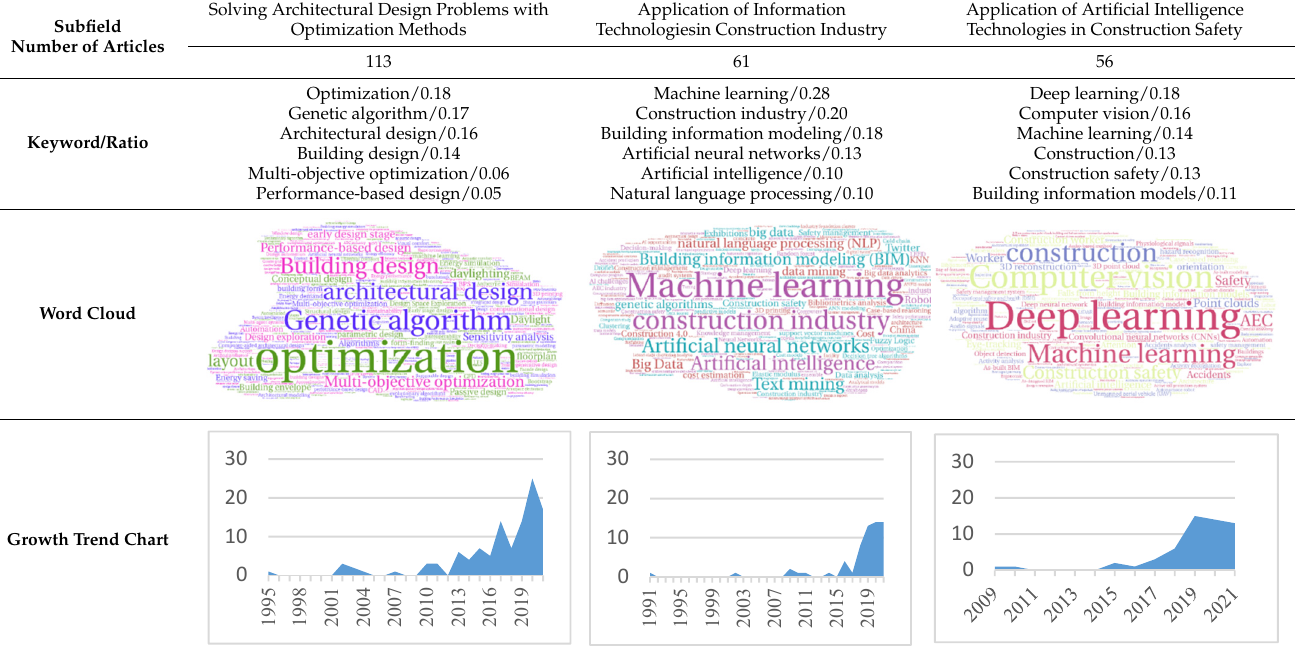
Table 2. Analytical results of cluster analysis.